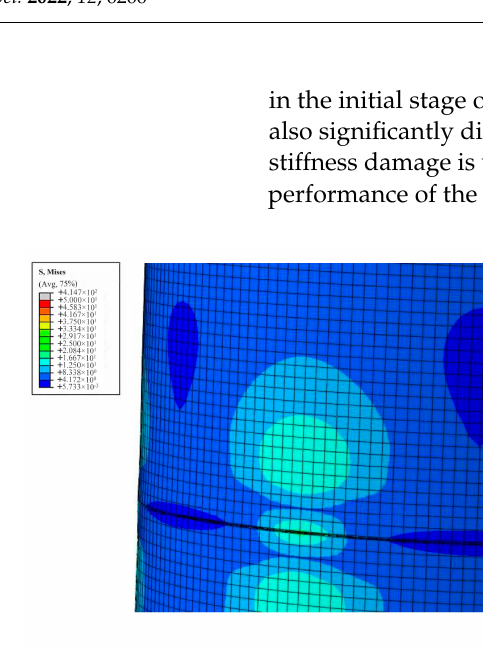
10 of 20 Figure 10. Force-displacement curve (static loads).